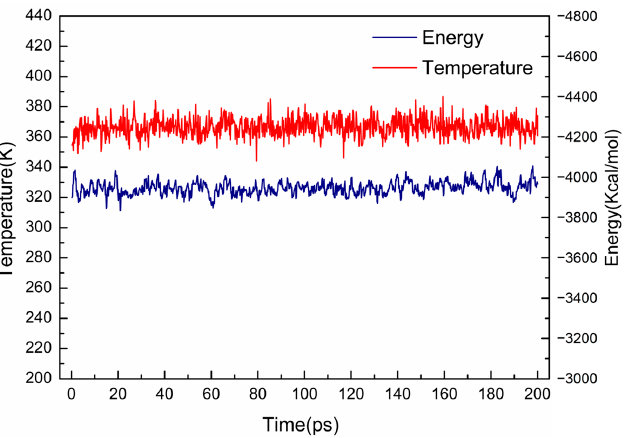
Figure 2. The plots of temperature and energy of PUC20 composite as simulation time.